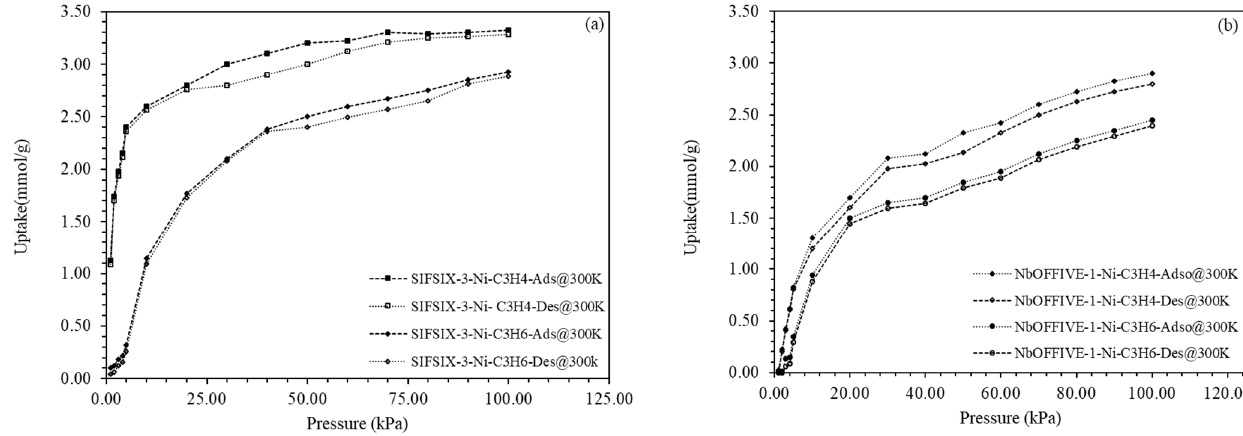
Figure 3. ( a ) adsorption/ desorption of C 3 H 4 on SIFSIX-3-Ni at 300 K and ( b ) adsorption/ desorption of C 3 H 6 on NbOFFIVE-1-Ni at 300 K.